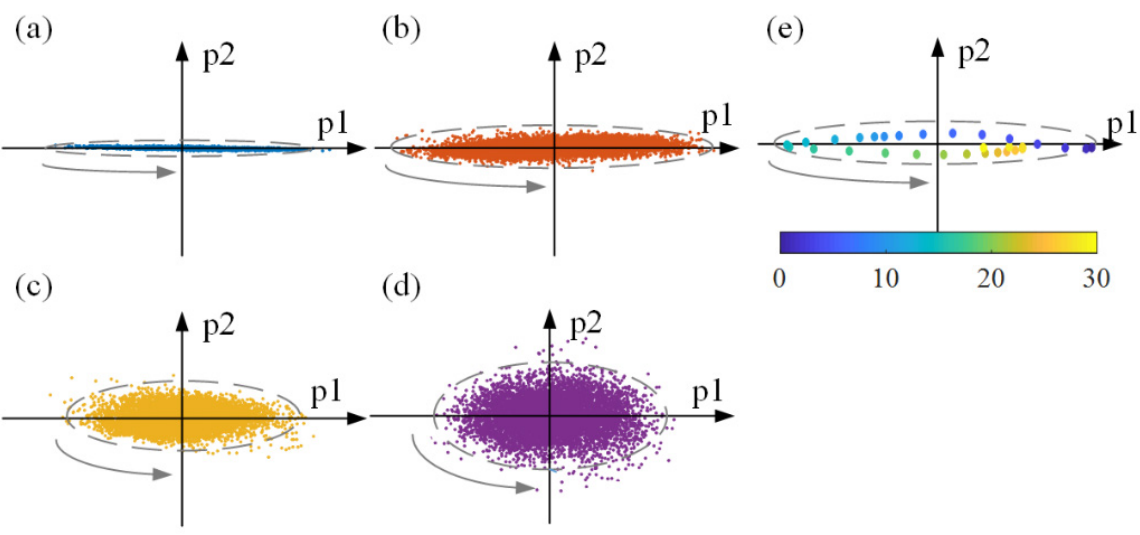
Figure 7. Schematic diagram of the trajectory under different acupuncture manipulation frequencies in latent dynamic space. ( a ) Pre-acupuncture, ( b ) 50 times/min, ( c ) 100 times/min, ( d ) 150 times/min. ( e ) An illustration exhibiting points’ evolution over time in ( b ). The color labels present the time order of each point, and the time step between points is 1/256 s. It can be seen that the units representing time-varying activity in the neural space converge to an elliptic attractor.